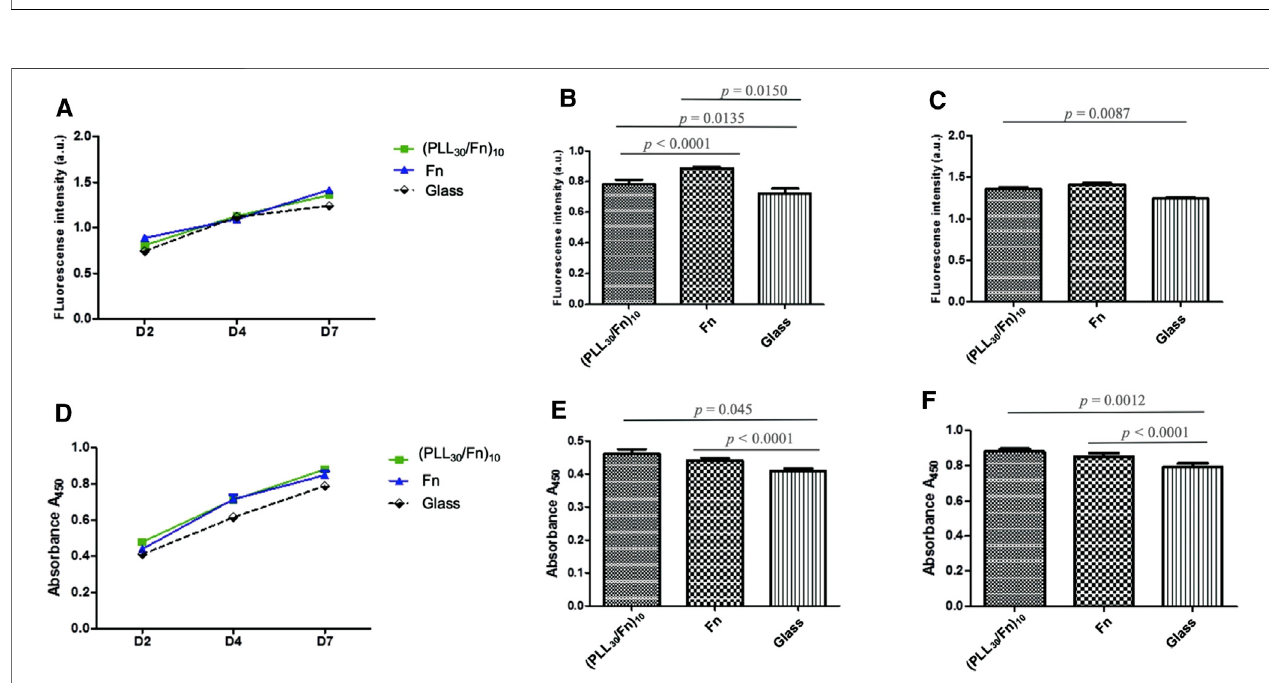
FIGURE 4 | Proliferation and metabolic activity of human gingival fi broblasts (HGF) on (PLL 30 -Fn) 10 fi lms, Fn monolayer, and glass coverslip. (A) CyQUANT ™ resultsofcellproliferationofHGFat2,4,and7 daysofincubation.Histogramsrepresentingmoreindetailcellproliferationat2 days (B) and7 days (C) ofincubation. (D) WST-1 quantitation of metabolic activity of HGF on different conditions over time. Histograms representing more in detail metabolic activity corresponding to 2 days (E) and 7 days (F) of incubation. Statistically different at p < 0.05.